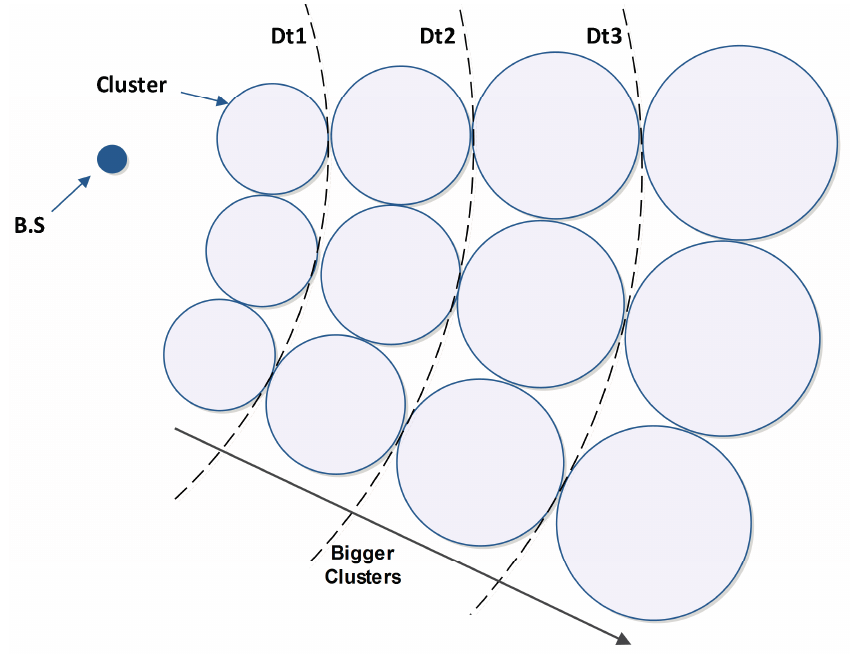
Figure 2. The cluster size is proportional to distance from